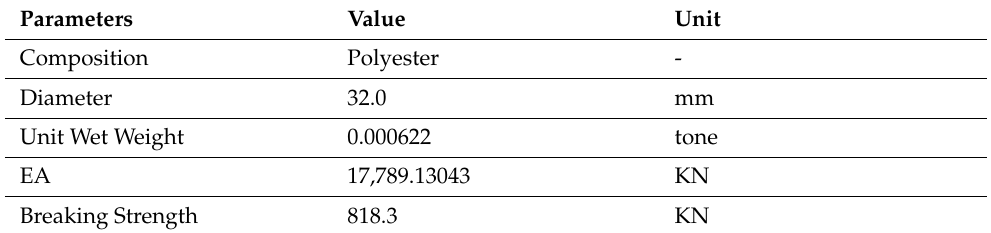
Table 3. Properties of mooring lines.